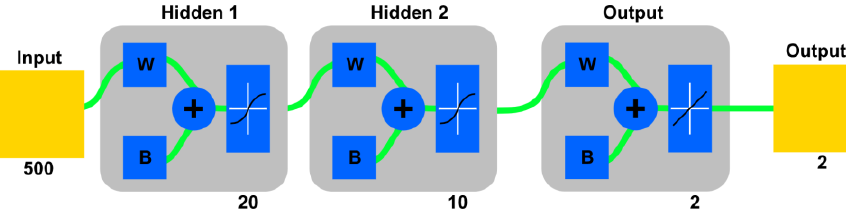
Figure 7. Mixed yarns: the structure of neural network traction properties (Adapted from [11]).